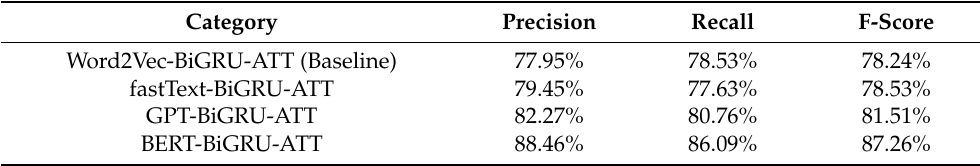
Table 3. Comparison of the effects of different word embedding